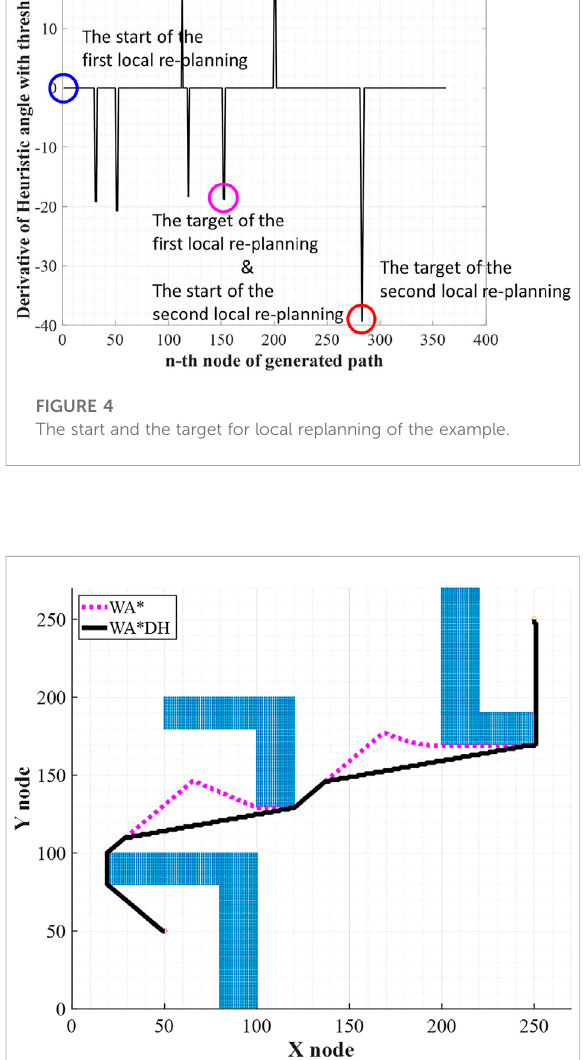
FIGURE 5 Initial and fi nal solution of